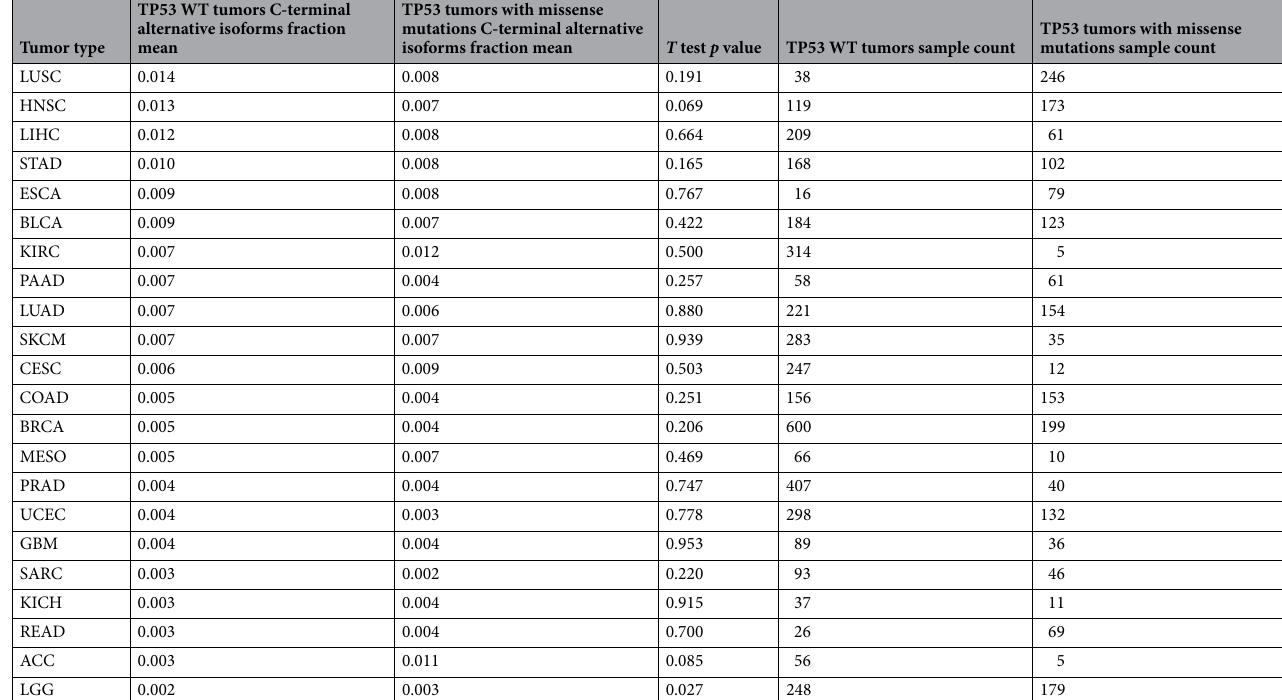
Table 2. Comparison of exonic fractions for C-terminal alternative isoforms across TCGA tumor types between TP53 WT tumors and TP53 tumors with missense mutations.